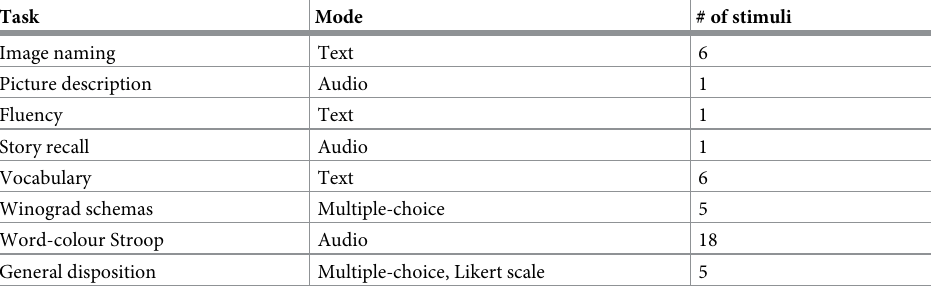
Table 1. Modality of language tasks, and the number of unique stimuli per session for each